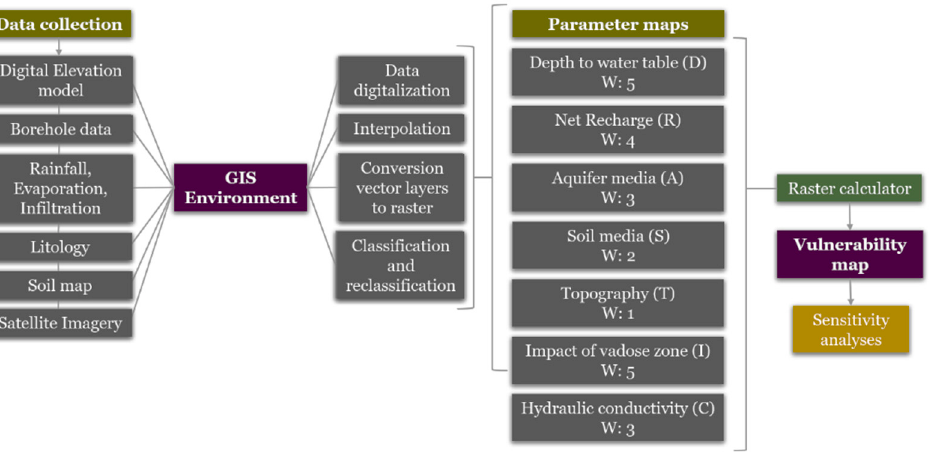
Figure 2. Flow chart used to develop the groundwater vulnerability map using the DRASTIC index in GIS.